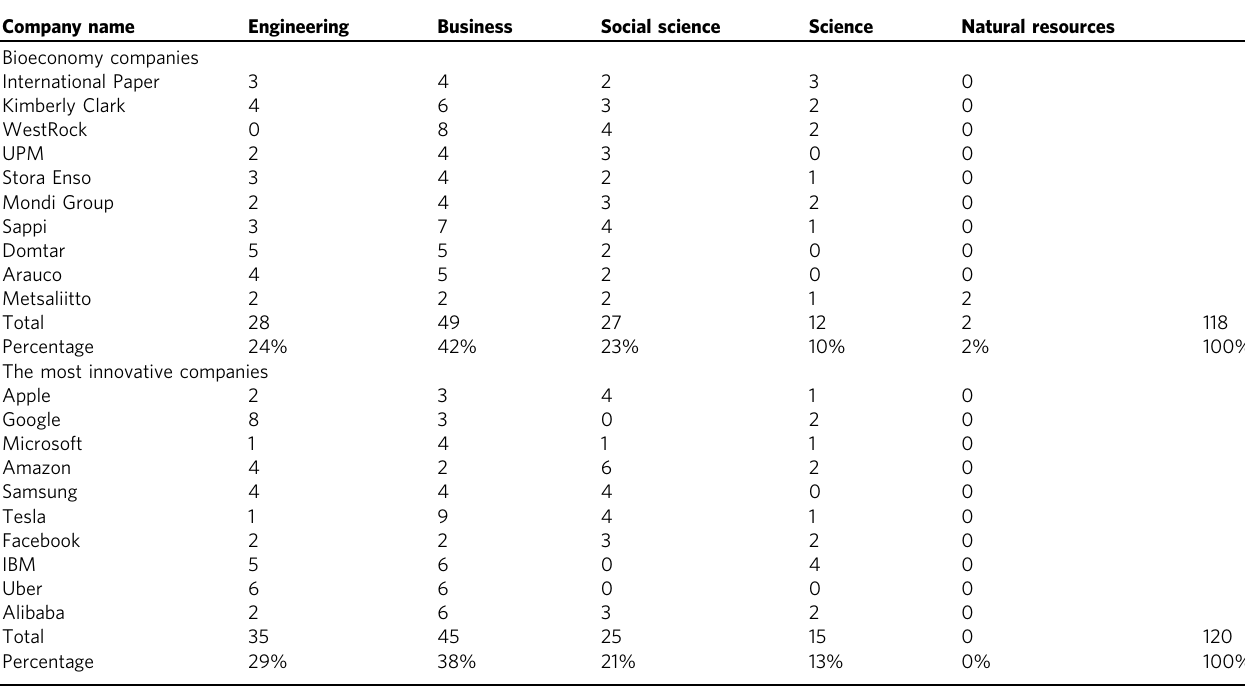
Table 1 Educational disciplines for boards of directors ’ members in both company groups. Company name